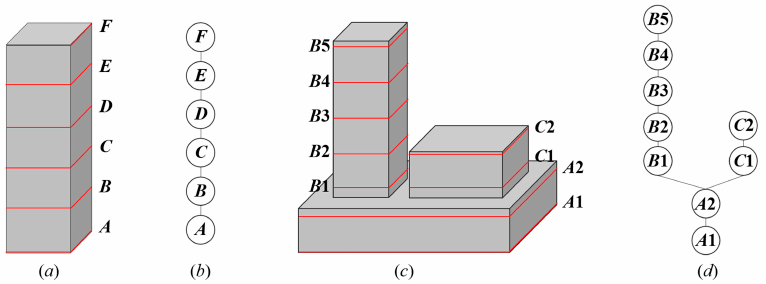
Figure 1. Illustration of graph-based localized contour tree representation of buildings: ( a ) contour representation of a single building; ( b ) a single-branch contour tree representation of the building shape shown in ( a ); ( c ) contour representation of a multi-layers building; and ( d ) a multi-branch contour tree representation of the building shape shown in ( c ).